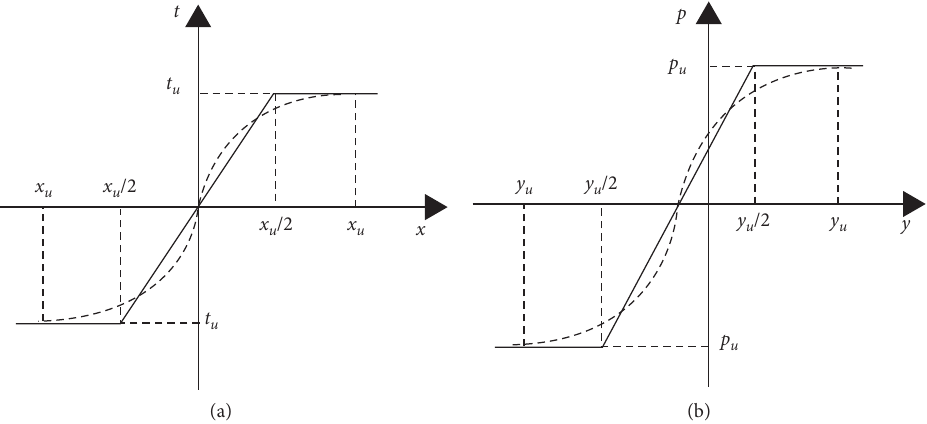
Figure 3: Force-displacement relationships of pipe-soil interaction in (a) axial and (b) transverse horizontal directions (modified after [10]).